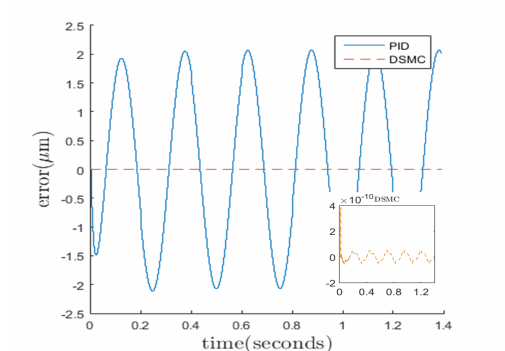
Fig. 8: Error for sine function. Table 4. MAXE and RMSE